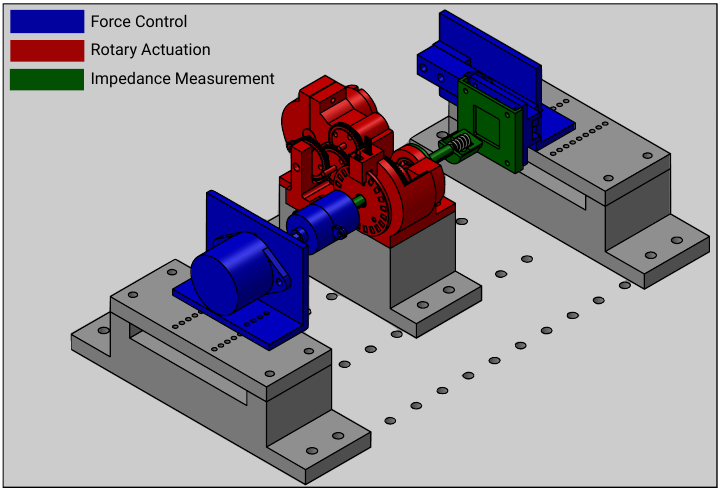
Figure 2. Test rig for abrasion characterisation, with independent force and rotary